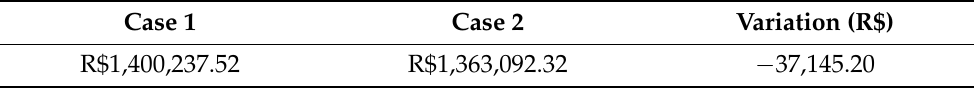
Table 7. Operating cost variation between Case 1 and Case